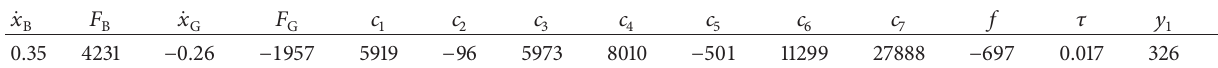
Table 3: The results of the optimization algorithm.